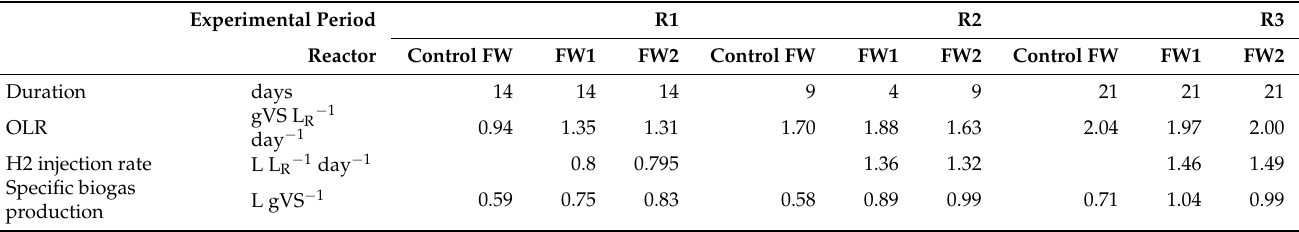
Table A6. Average in-situ biomethanation results for food waste (FW)-fed reactors across operational periods